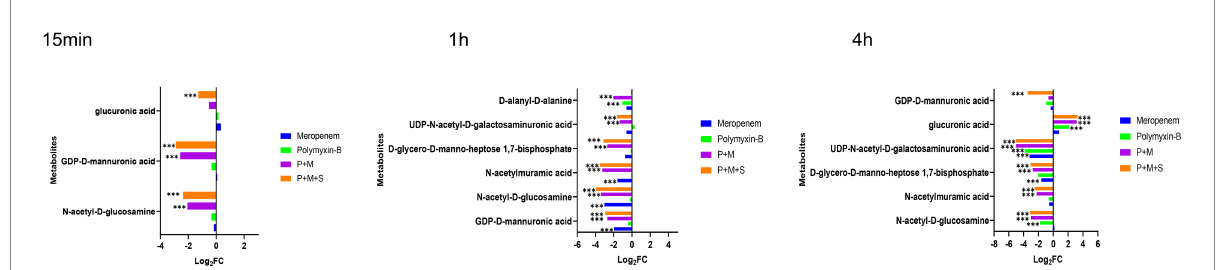
FIGURE 3 Perturbations of LPS and peptidoglycan metabolism pathway in Acinetobacter baumannii treated with antibiotics as monotherapy and combination therapy at 15 min, 1 and 4 h. Significantly perturbed metabolites were selected based on log 2 FC ≤ − 1 or ≥ 1, p < 0.05 and VIP > 1;